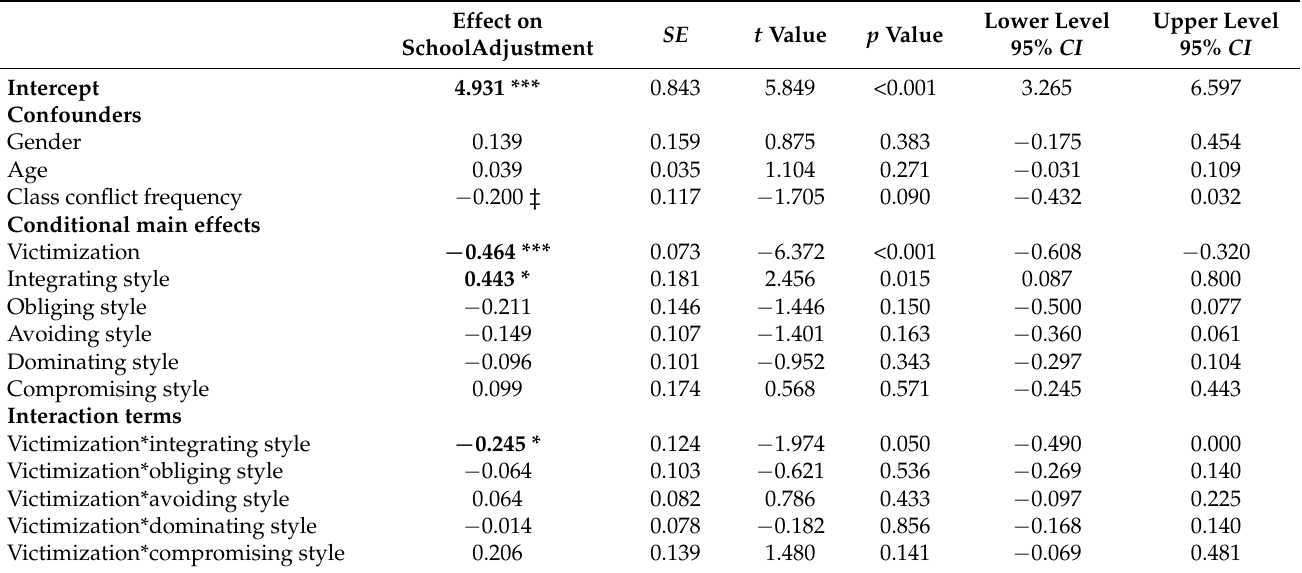
Table 3. The Effect of Victimization on School Adjustment Moderated by Conflict Management Styles while Controlling for Gender, Age and Class Conflict